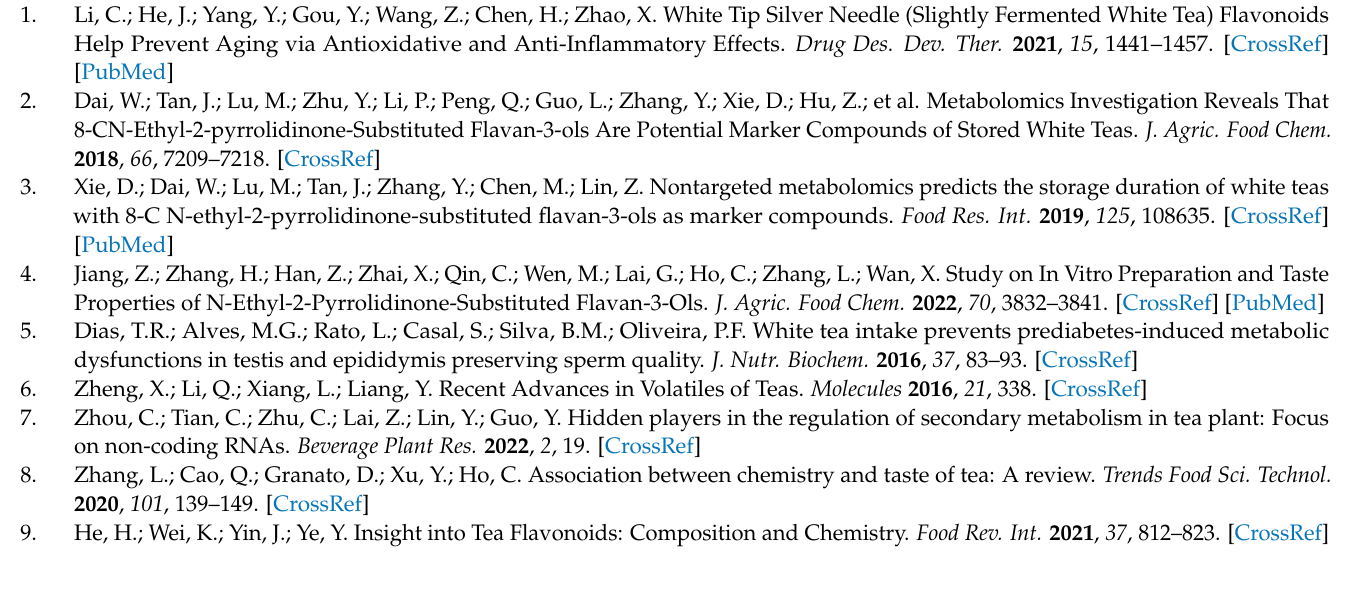
Table S1: The headspace solid-phase micro extraction (HS-SPME) and gas chromatography–mass spectrometry (GC-MS) conditions, Table S2: Average temperature for production months, Table S3: The qualitative results for the VOCs in SPWTs and APWTs, Table S4: Content of different types of VOCs in SPWTs and APWTs, Table S5: VIP and p -values of the 54 volatile components, Table S6: The VOCs with OAVs ≥ 1 and VIP >